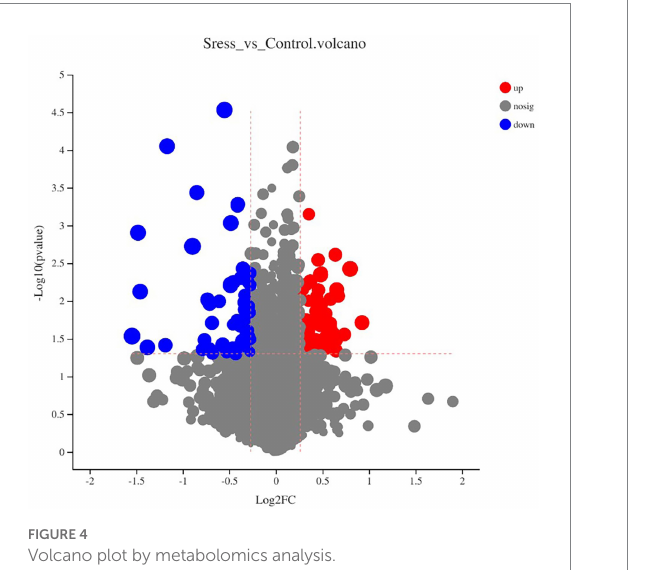
FIGURE 5 KEGG pathway significantly enriched in differential metabolites. The size of each spot represents the metabolite number, and the color represents -log10 ( p -value).